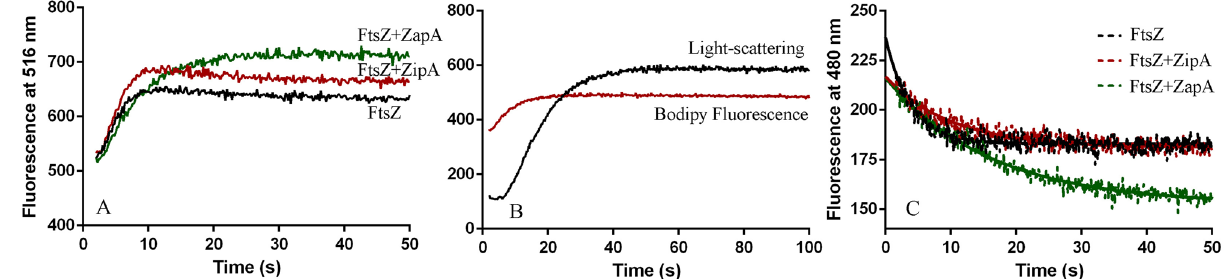
Figure 5. Dynamic properties of EcFtsZ in the absence of or in the presence of EcZipA or EcZapA measured by fluorescence and light-scattering assays. Note that these experiments used EcFtsZ, not PaFtsZ. These experiments were done in HMK buffer. (A) Kinetics of EcFtsZ pfs assembly measured by bodipy fluorescence. Assembly of 7 µM EcFtsZ alone is compared with assembly with 10 µM ZapA or ZipA. (B) Assembly of 7 µM EcFtsZ plus 10 µM EcZapA measured by bodipy fluorescence, compared to bundling measured by light scattering. (C) Exchange of subunits between EcFtsZ pfs was measured by FRET assay, for 7 µM EcFtsZ alone or mixed with 10 µM ZipA or